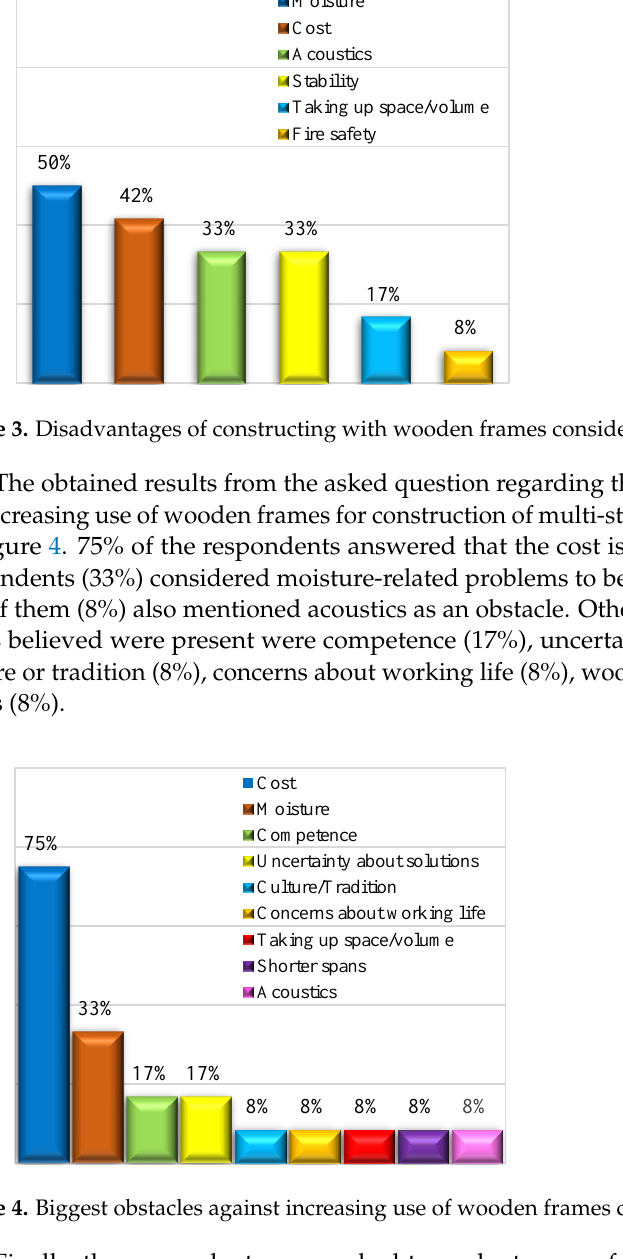
Figure 2. Advantages influencing decision of ERs to choose wooden frames.